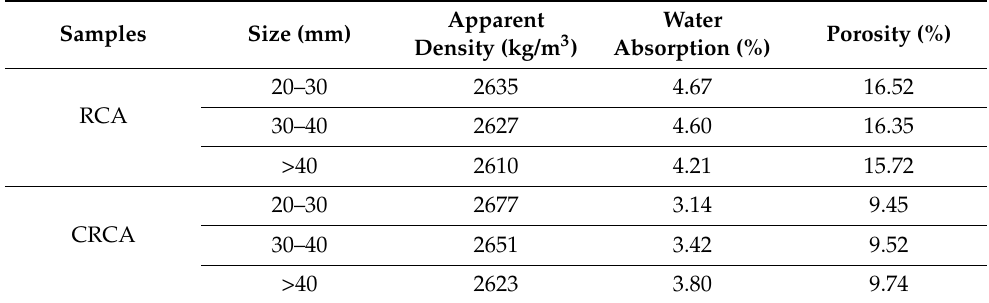
Table 4. Properties of RCA and CRCA [6]. Reproduced with permission from [6], Elsevier, 2019.